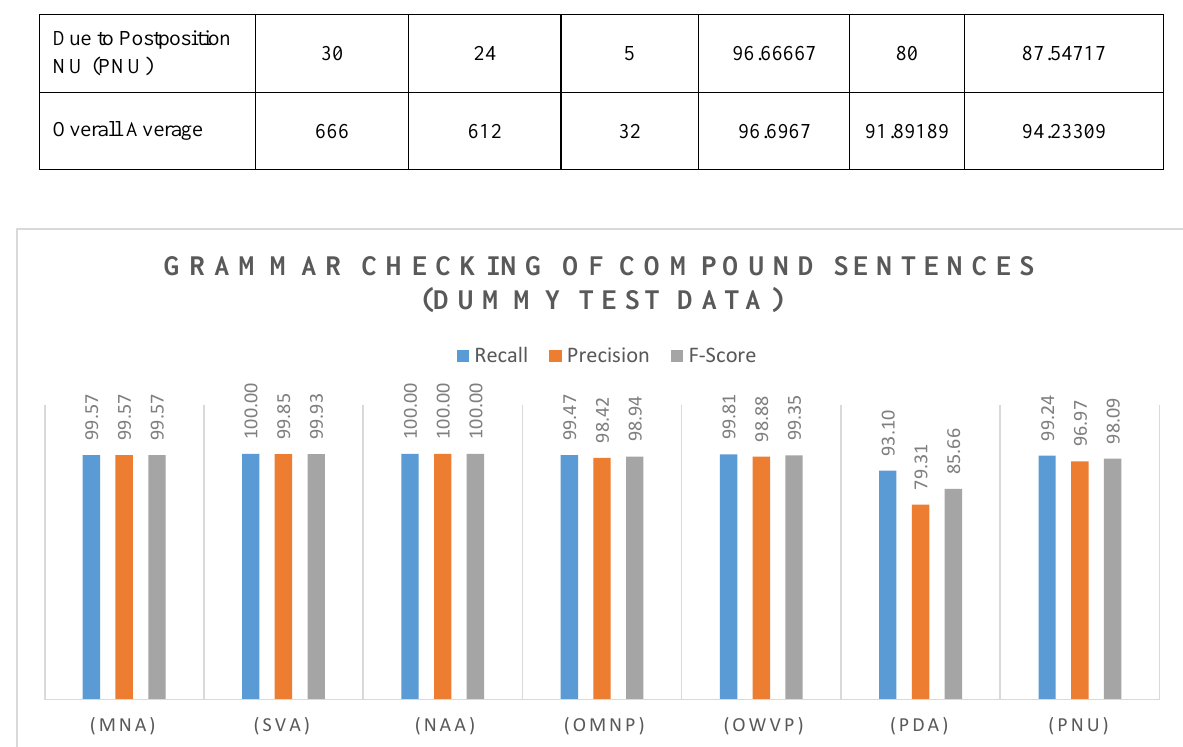
Figure 3.1 : Experimental Evaluation of Grammar checking of compound sentences (Dummy Test Data)